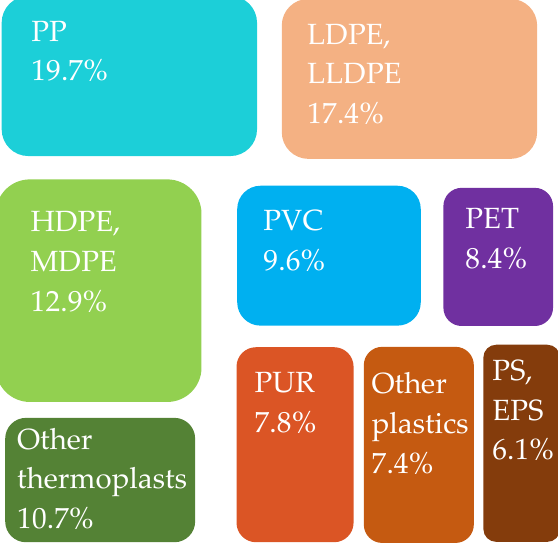
Figure 8. Plastics converters ’ demand in the EU27 + 3 by polymer type in 2020. Made based on [3].